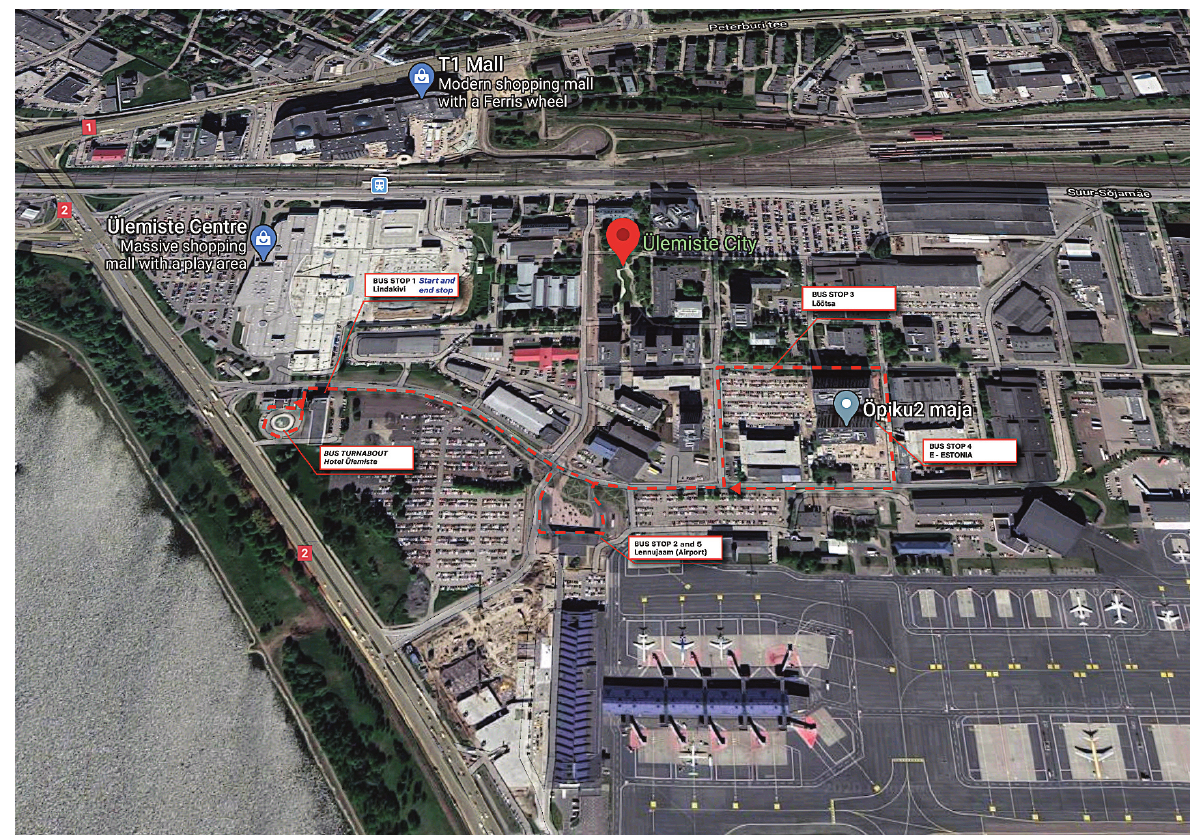
Fig. 1 . Test route and stops in Ülemiste City.